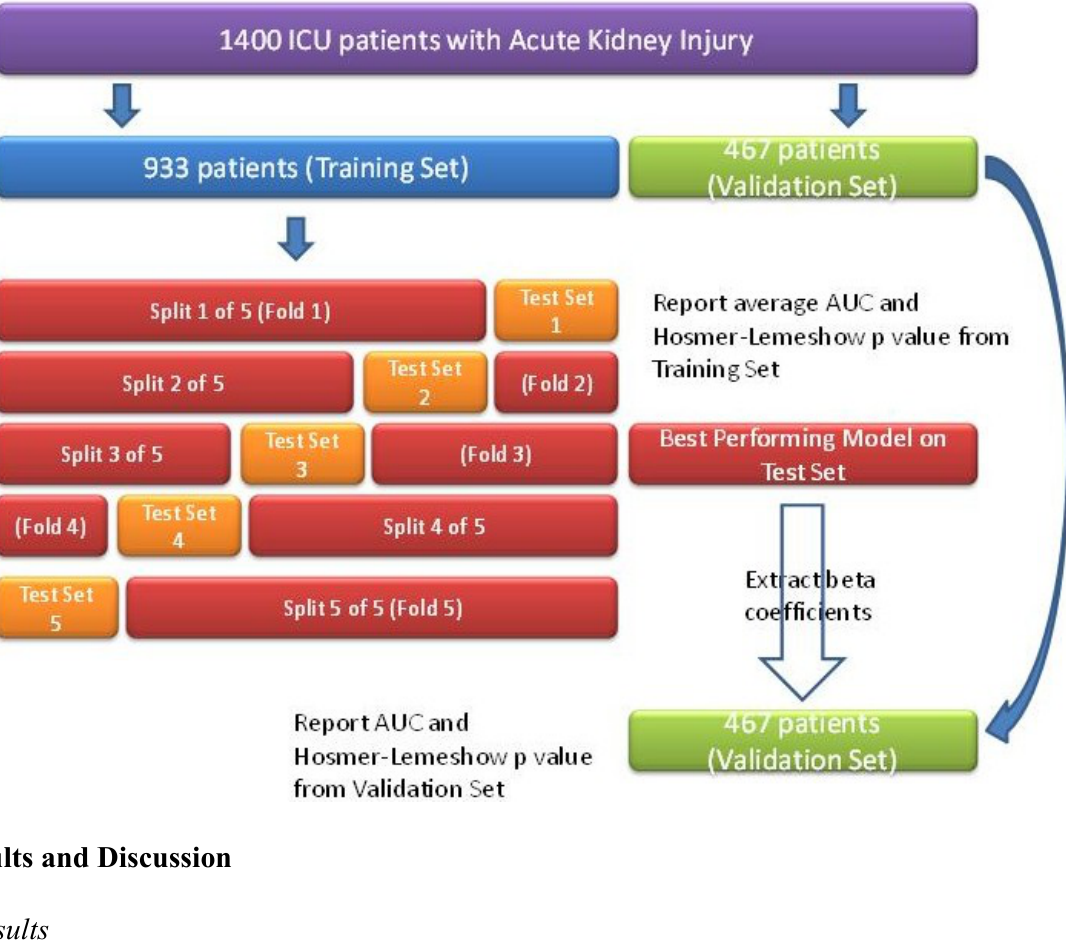
Figure 1. Cross-validation method for ICU patients admitted with acute kidney injury (AKI). AUC = Area under the Receiver Operating Characteristic